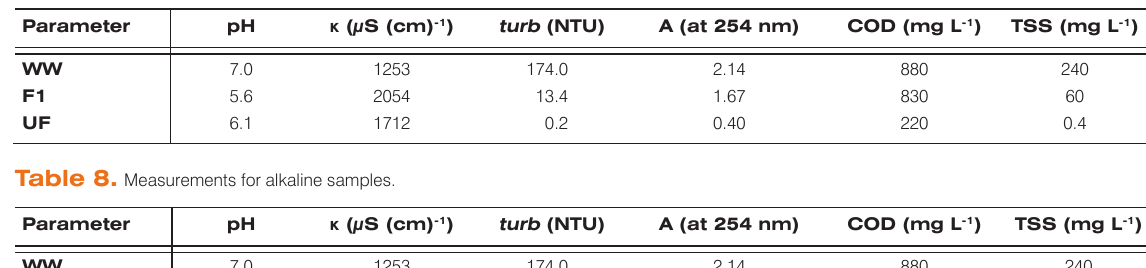
Table 7. Measurements for acidic samples.